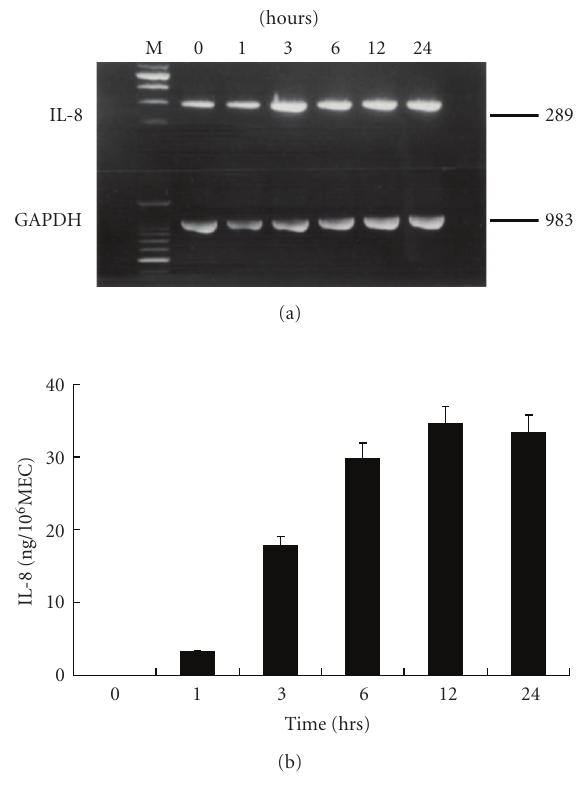
Figure 2: The kinetics of IL-8 with time. The expression of IL- 8 mRNA (a) continued to increase from 3hrs to 24 hrs after incubation. The concentration of secreted IL-8 (b) was significantly increased from 3 hours and peaked at 12 hours after incubation.